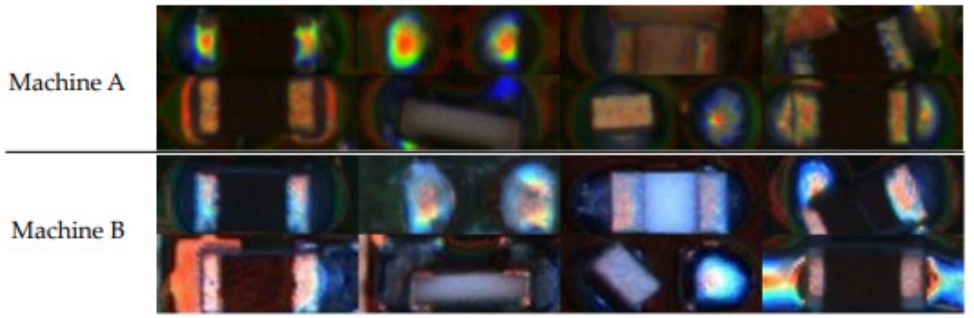
Figure 6. Color scale differences of A and B machines.